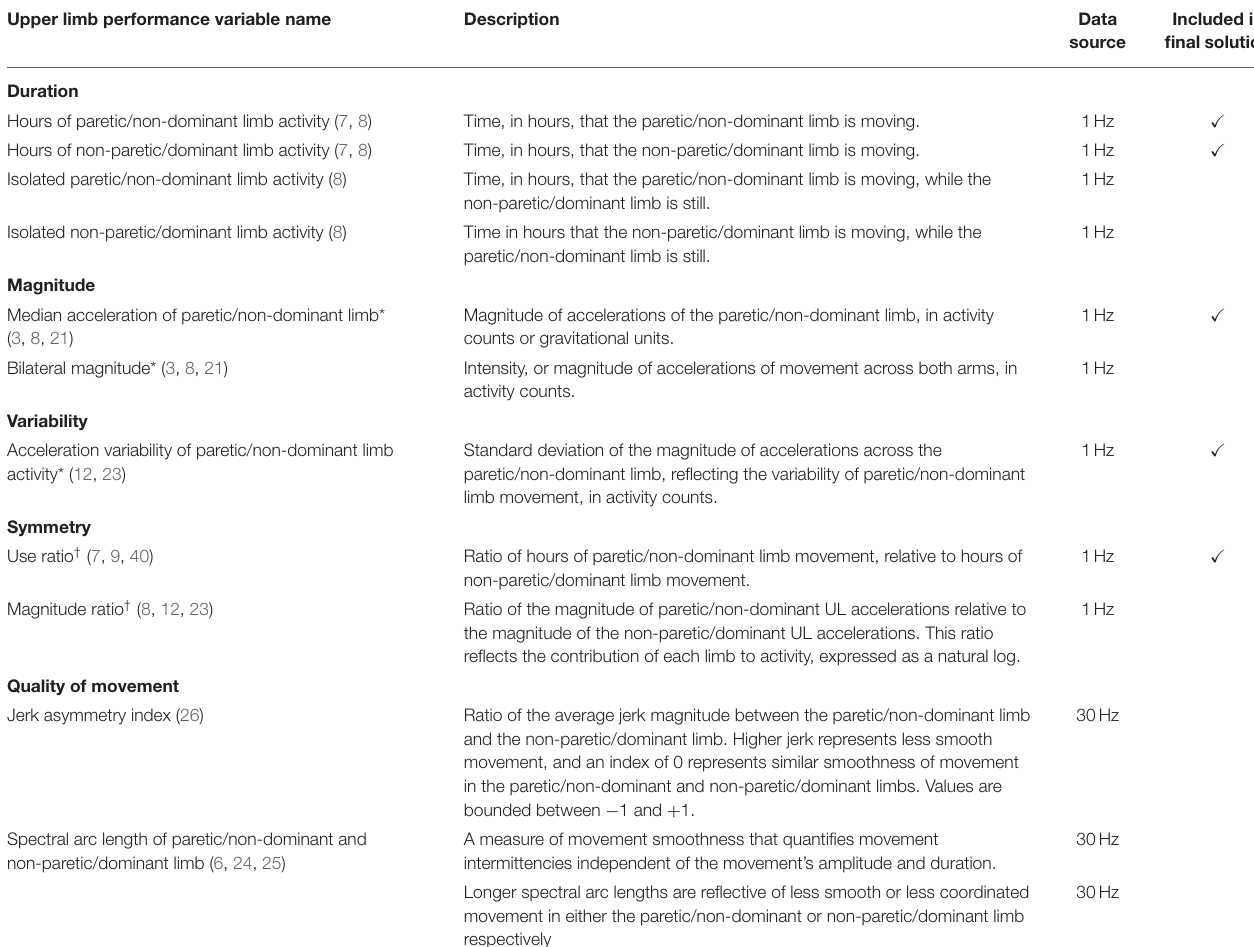
TABLE 1 | Upper limb performance